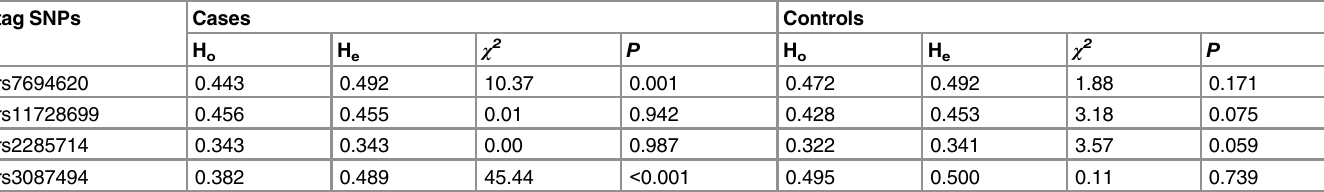
Table 1. The Hardy-Weinberg equilibrium results by goodness-of-fit Chi-square tests.